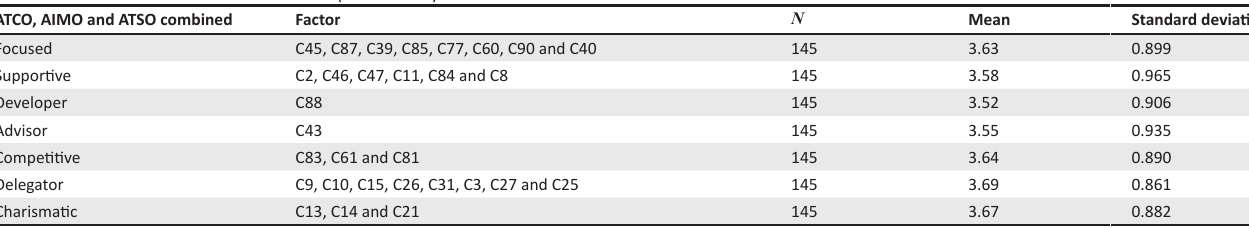
TABLE 4: Leader behaviour factors and items (noted as ‘C’).